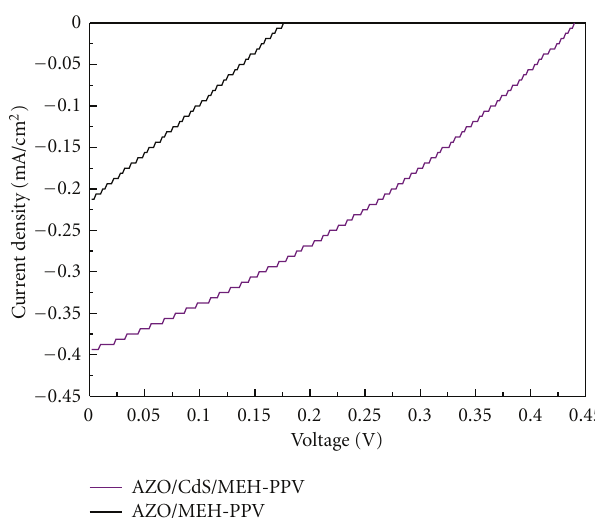
Figure 4: I–V characteristics of AZO/CdS/MEH-PPV and AZO/MEH-PPV